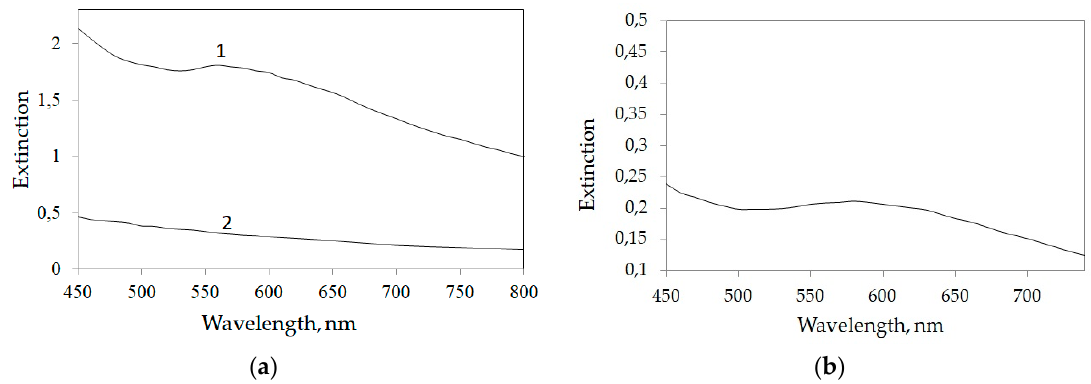
Figure 2. Optical absorption spectra of NiFe 2 O 4 nanoparticles ( a ) before (2) and after (1) gold deposition from the alkaline (pH = 10) solution containing 0.1 mol/L HAuCl 4 and 0.03 mol/L methionine at 37 °C for 4 h, and spectra of solution ( b ) remaining after NiFe 2 O 4 @Au nanoparticles (NPs) magnetic separation.